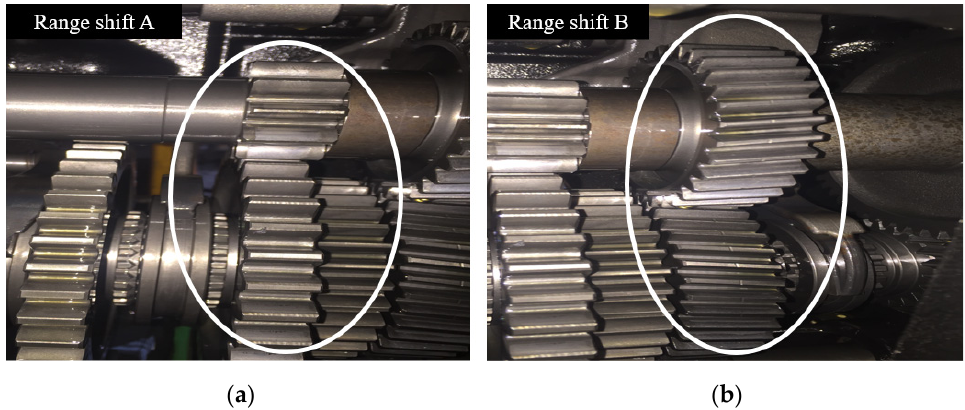
Figure 11. Results of the dynamometer test for the range shift gears: ( a ) range shift A gears; ( b ) range shift B gears.